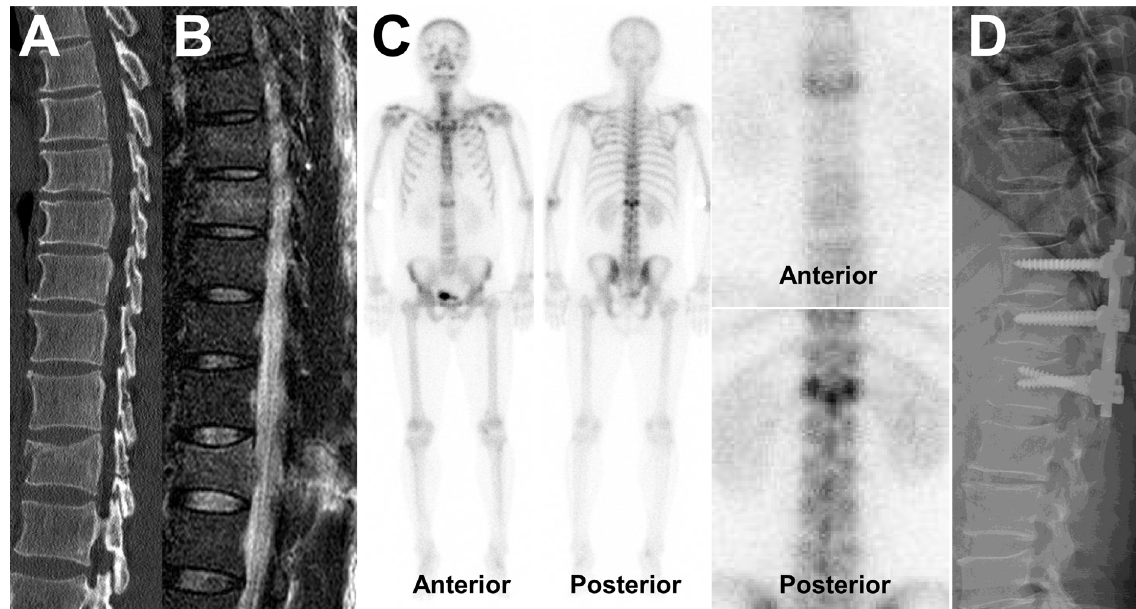
Figure 4. Representative images of a burst fracture of T12 in a 44-year-old patient. ( A ) Computed tomography and ( B ) magnetic resonance images show a T12 burst fracture with damage to the posterior elements of the vertebra. The TLICS was calculated as 7. ( C ) Bone scan images; analysis revealed that B B was 3, B P was 2, and their sum (B TS ) was 5. The fracture was assessed as unstable and ( D ) the patient underwent posterolateral fusion at the level of